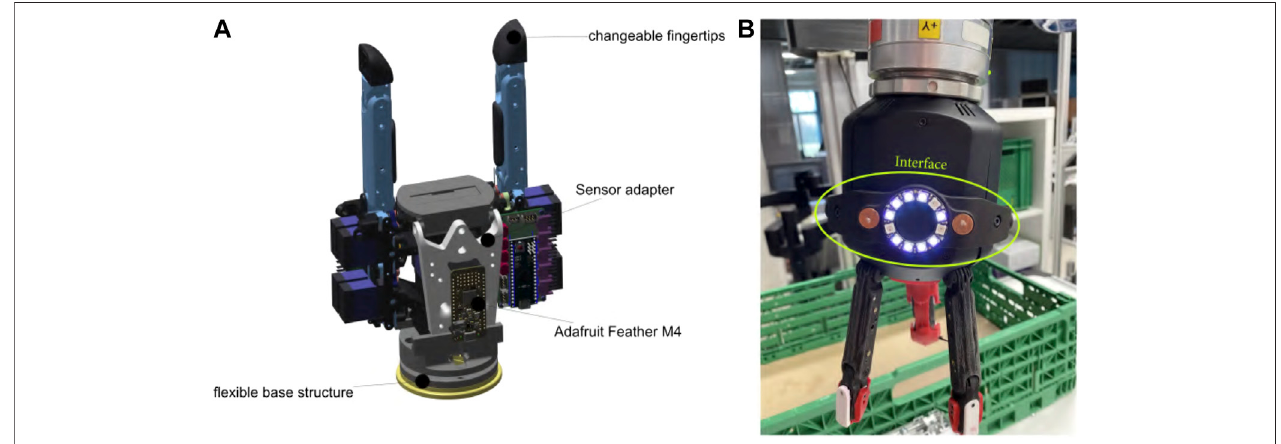
FIGURE 3 | CLASH 2F gripper. (A) Two- fi ngered gripper with two thumb modules and a fl exible base structure. (B) User interface for commanding the